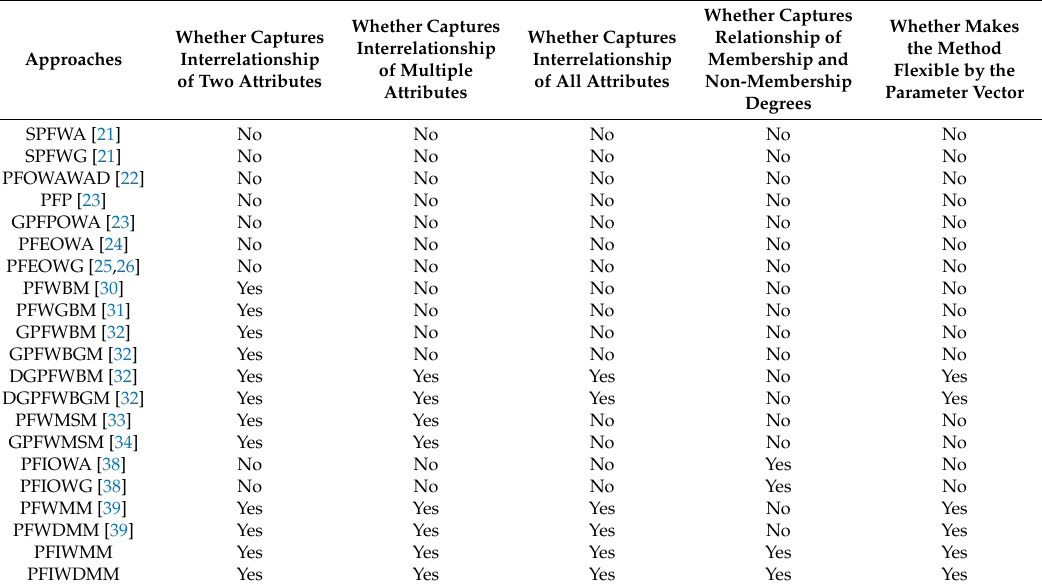
Table 2. Comparison of different aggregation